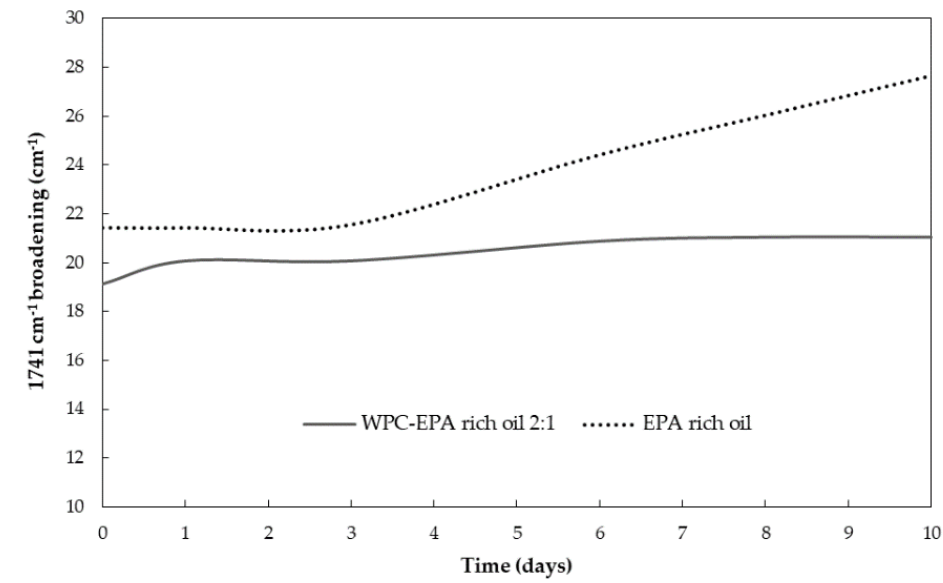
Figure 5. Peak widening of the free EPA-rich oil and the encapsulated EPA-rich oil into WPC, obtained as the 1741 cm − 1 broadband at half maximum, over UV-light exposure time.